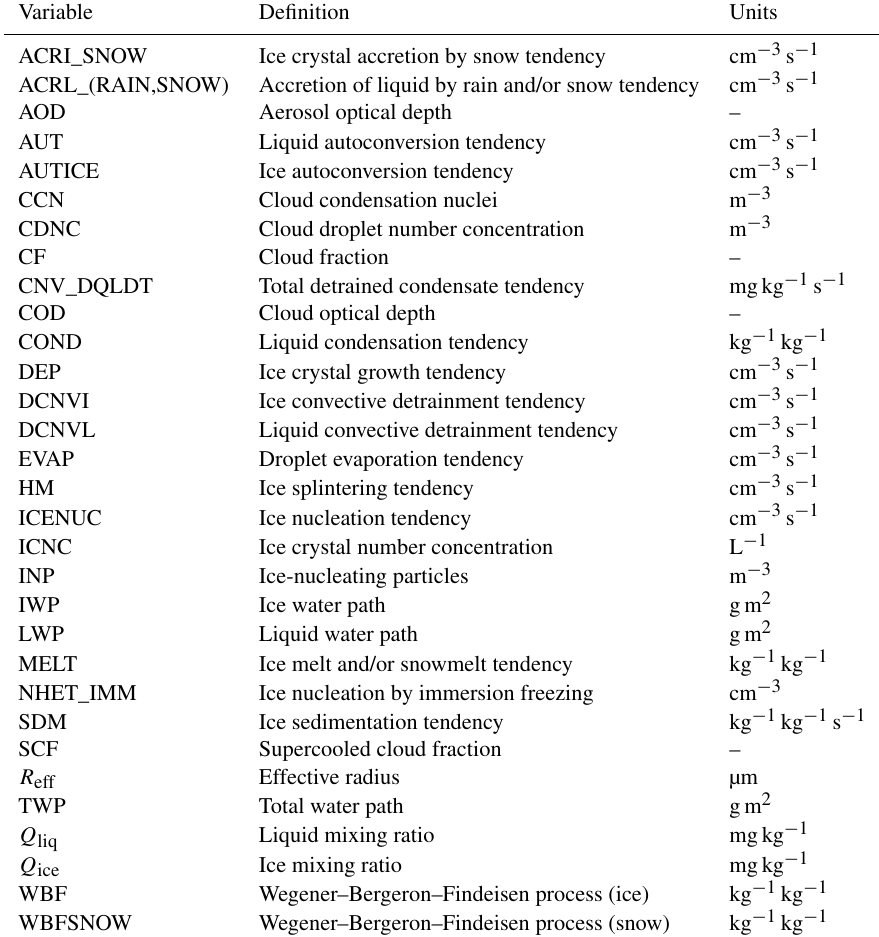
Table 1. Variable definitions and acronyms.